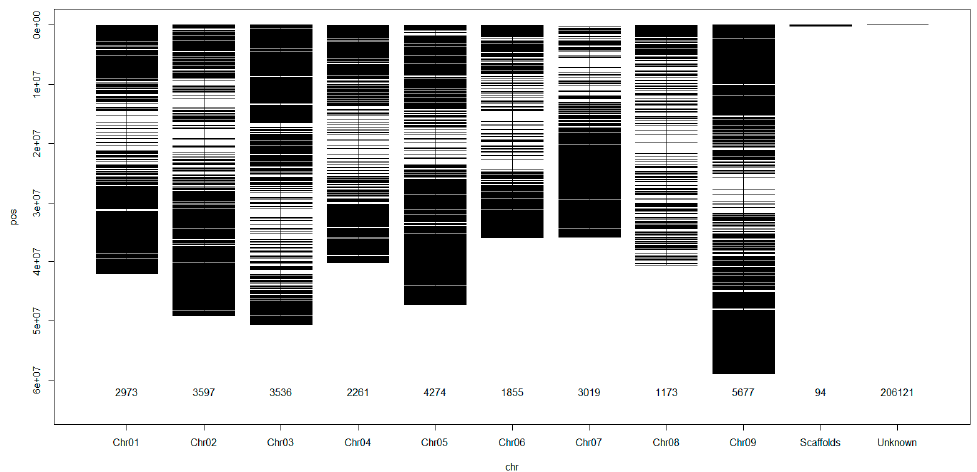
Figure 3. Genome ‐ wide distribution of the SNP markers across the nine chromosomes of Setaria italica reference genome.